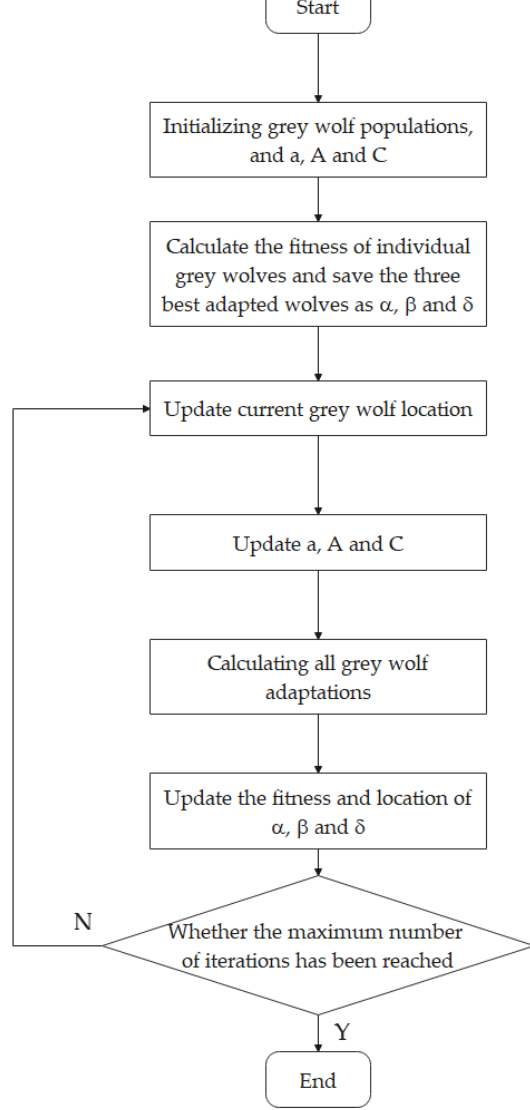
Figure 9. Flow chart of the Grey Wolf optimization algorithm.